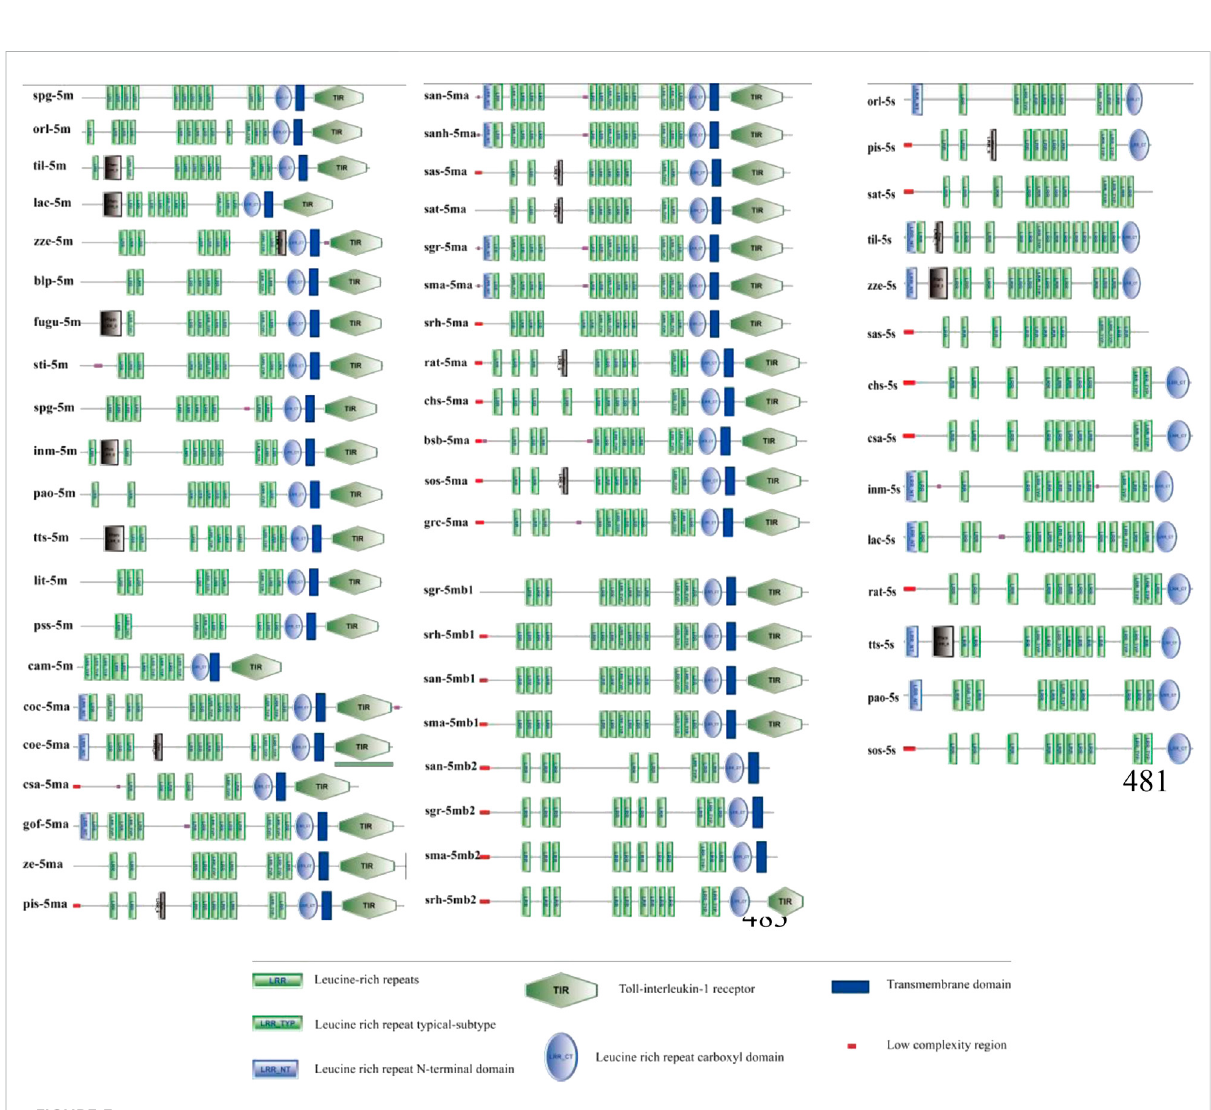
FIGURE 3 The domain features of TLR5 genes among fi shes. Detailed abbreviation of each species is available in Table